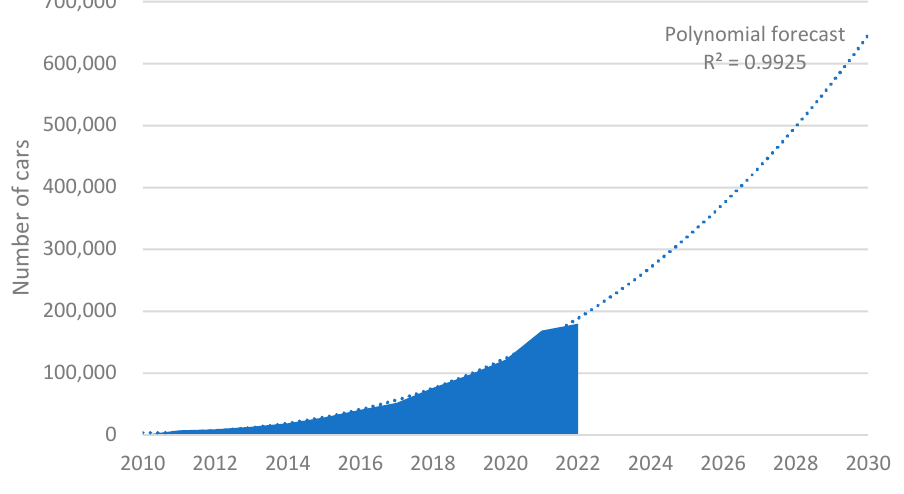
Figure 6. Total number of BEVs and PHEVs in the EU. Source: EAFO [89]. Table 1. Average cost of fuel per 100 km by selected European country (2022 1st